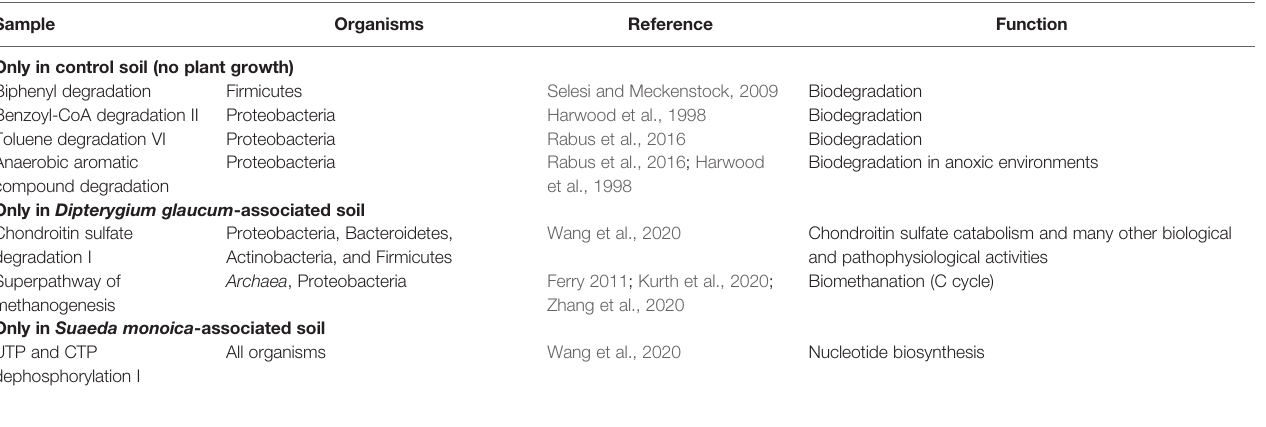
TABLE 1 | Unique pathways detected in various samples and their functions. Sample